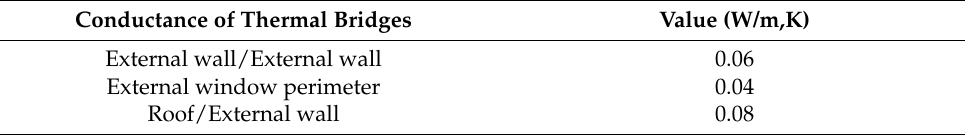
Table 2. Conductance of thermal bridges in the studied